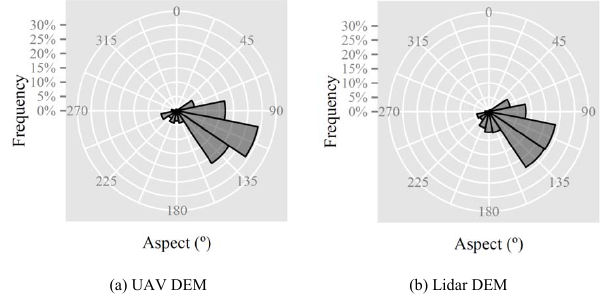
Figure 10. Distribution of terrain aspect. The aspect values are in degrees. The outer number represent the cardinal directions in de- grees.